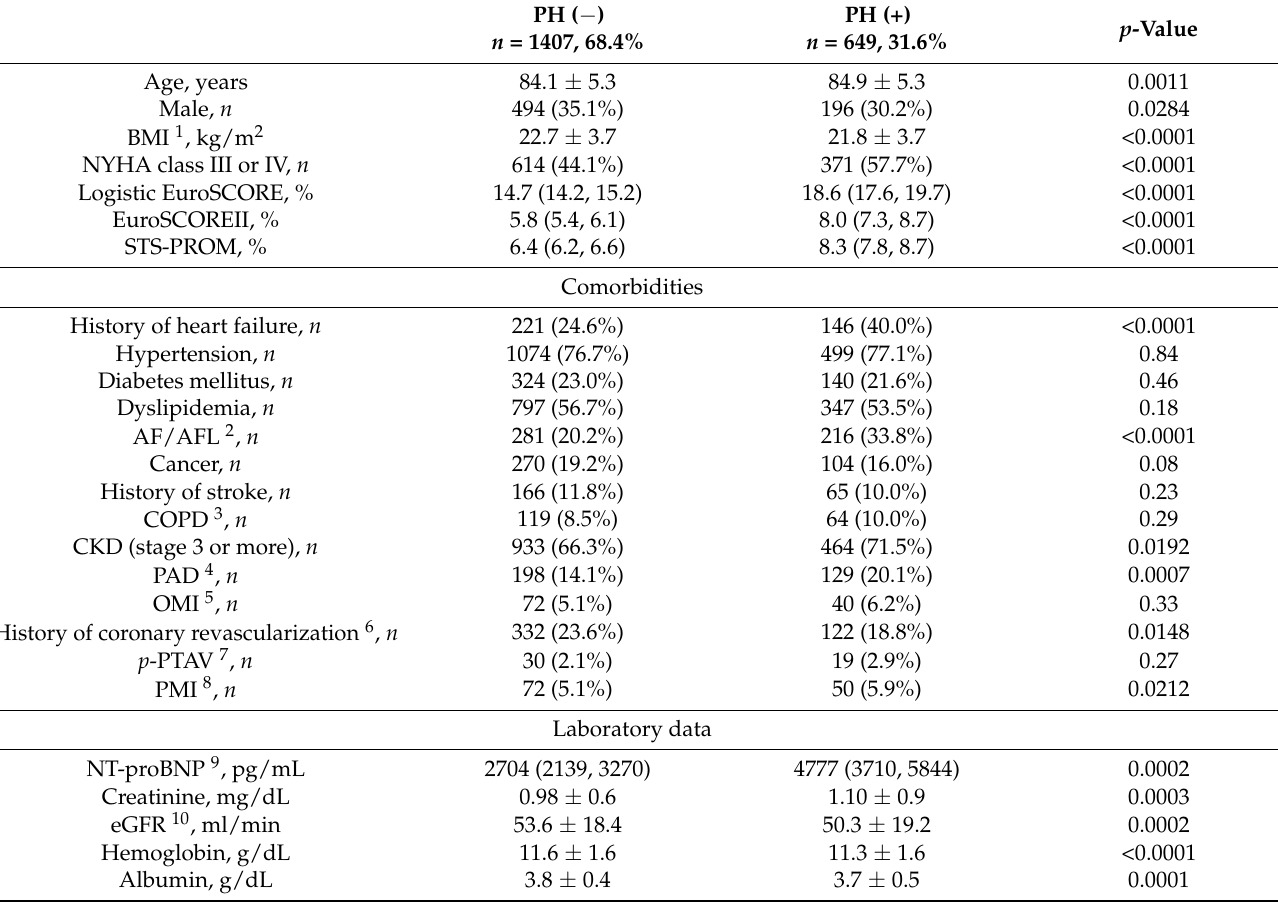
Table 1. Baseline characteristics of PH (+) vs. PH ( − )